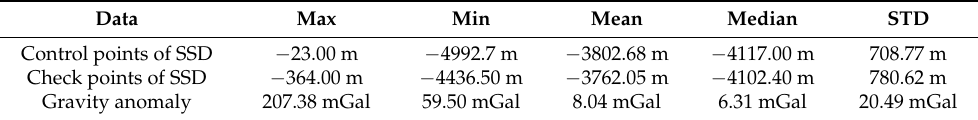
Table 1. Statistical results of the experimental data.